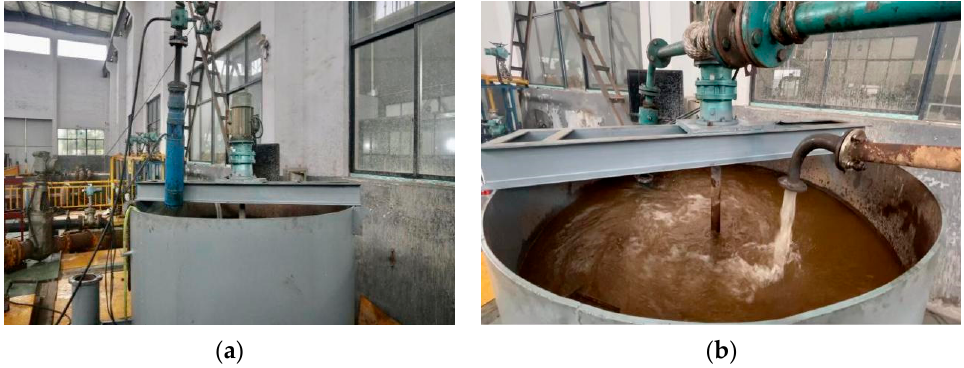
Figure 29. Test site: ( a ) test pump installation; ( b ) test process diagram.